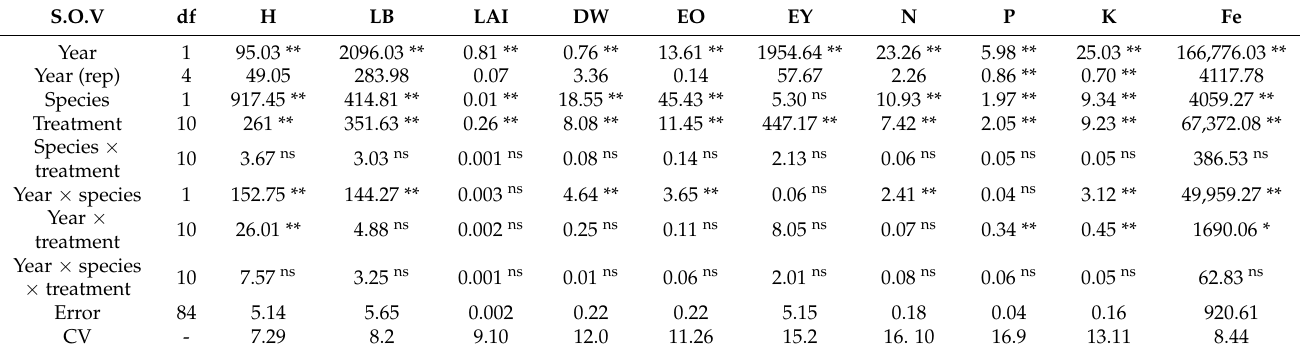
Table 3. Summary of combined analysis of variance on savory studied traits.